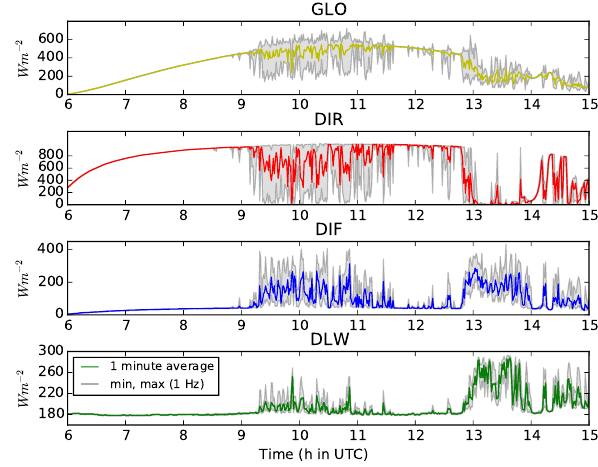
Figure 4. Sample of ARAD data measured at the SON station on 3 November 2014 between 06:00 and 15:00UTC. GLO denotes the global radiation on a horizontal plane, DIR the direct solar radiation on a plane normal to the direct beam, DIF the diffuse radiation on a horizontal plane and DLW the downward longwave radiation.